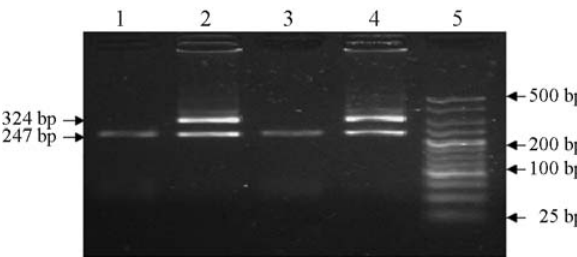
Figure 1 - Electrophoretogram of PCR product generated by amplifica- tion of genomic DNA using gene specific primers. Lane 1 and 3 # 247 bp fragment of normal animal, lane 2 and 4 # 324 bp and 247 bp fragments of carrier animals, lane 5# 25 bp DNA